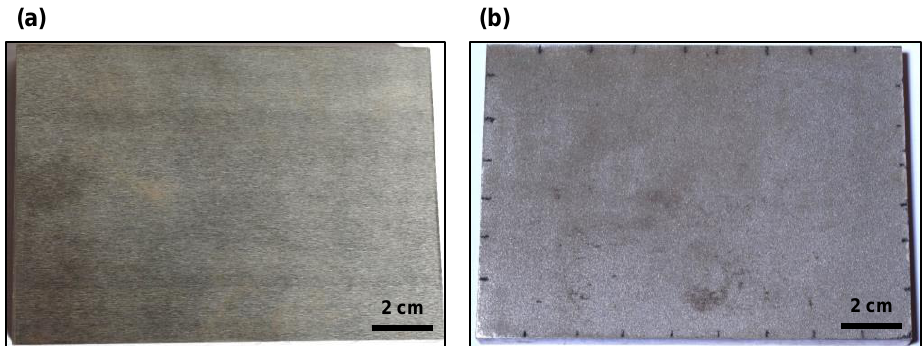
Figure 2. Grain size distribution curves of JEZ-1, JSC Mars-1 and MMS-1.